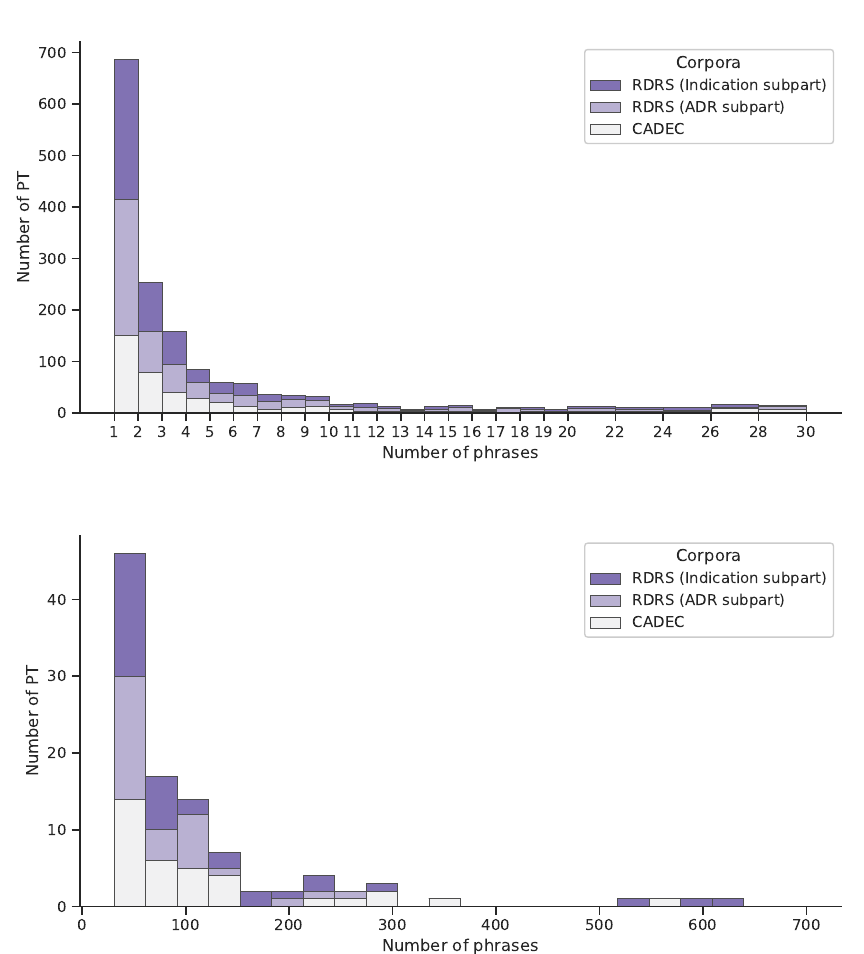
Figure 1. Histograms of “Phrase counts on PT” distribution for CADEC and RDRS corpora (( Top pic- ture ) number of phrases from 1 to 30; ( Bottom picture ) number of phrases from 31 to